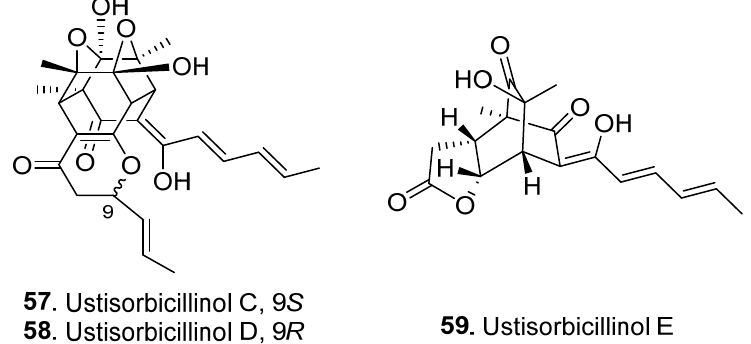
Figure 3. Structures of the bisorbicillinoids ( 39 – 59 ) isolated from fungi.